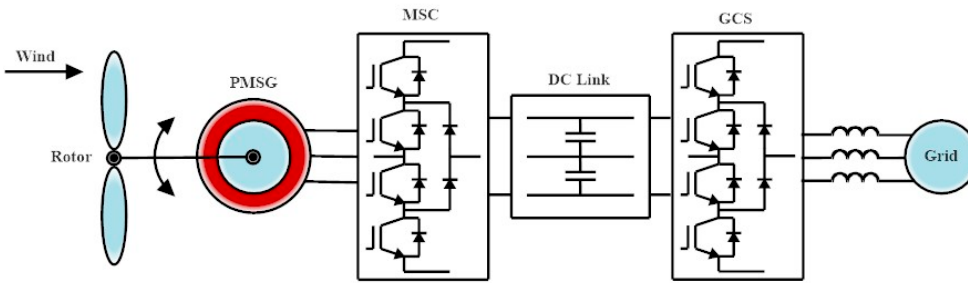
Figure 19. Multilevel converter. 590